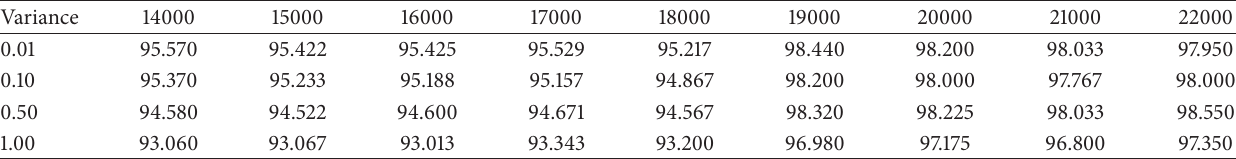
Table 6: Classification accuracy rates under different variances (%).